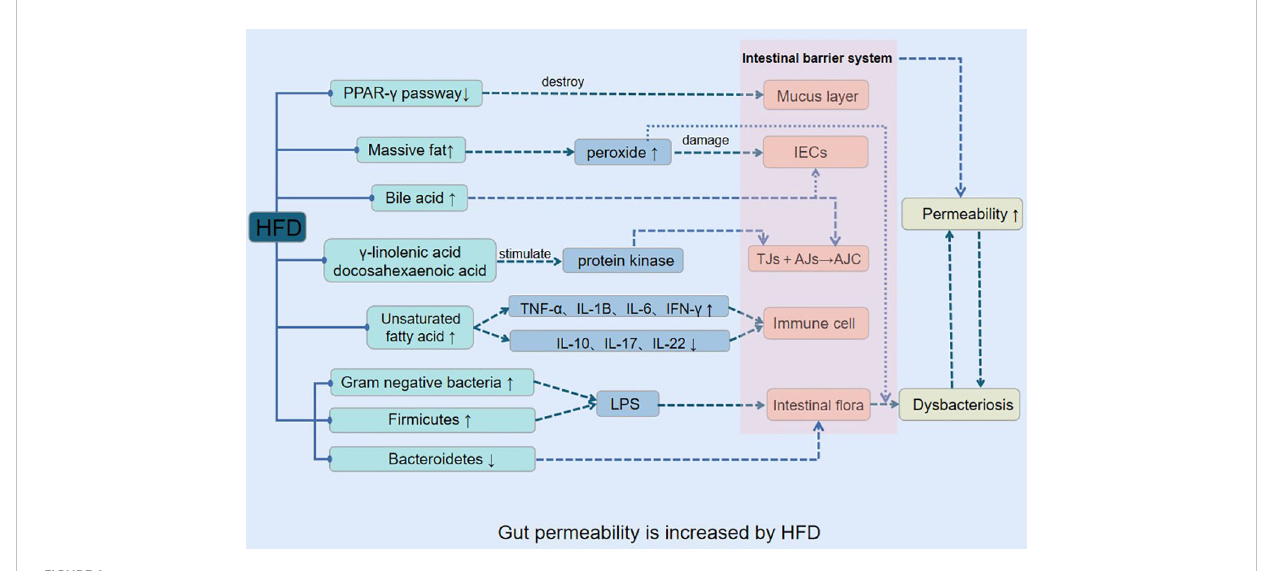
FIGURE 1 Gut permeability is increased by